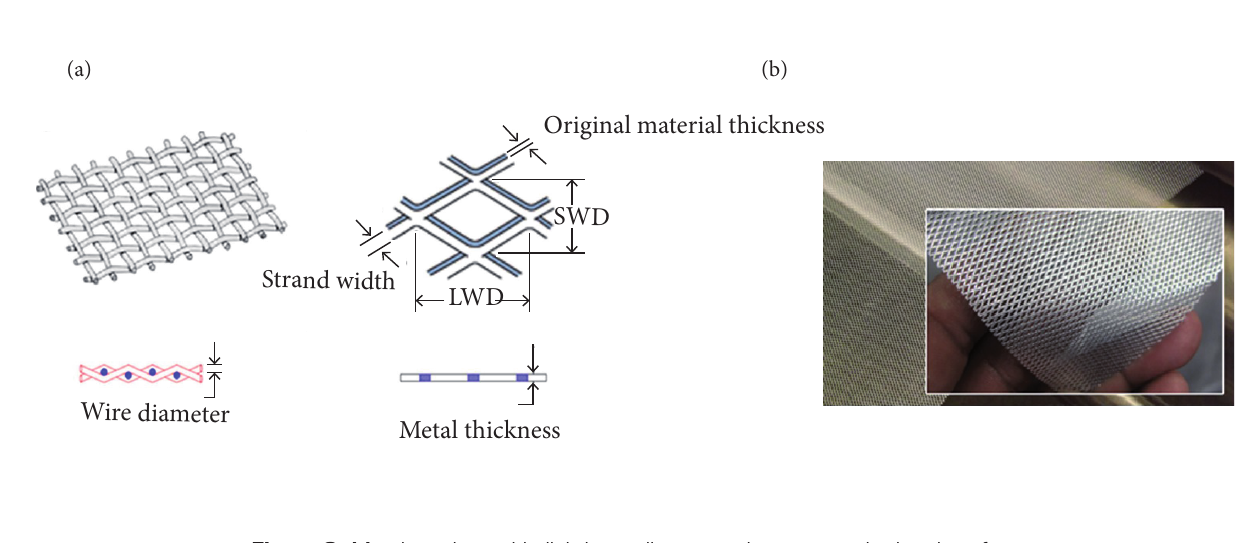
Figure 9. Metal mesh used in lighting strike protection systems in the aircrafts: